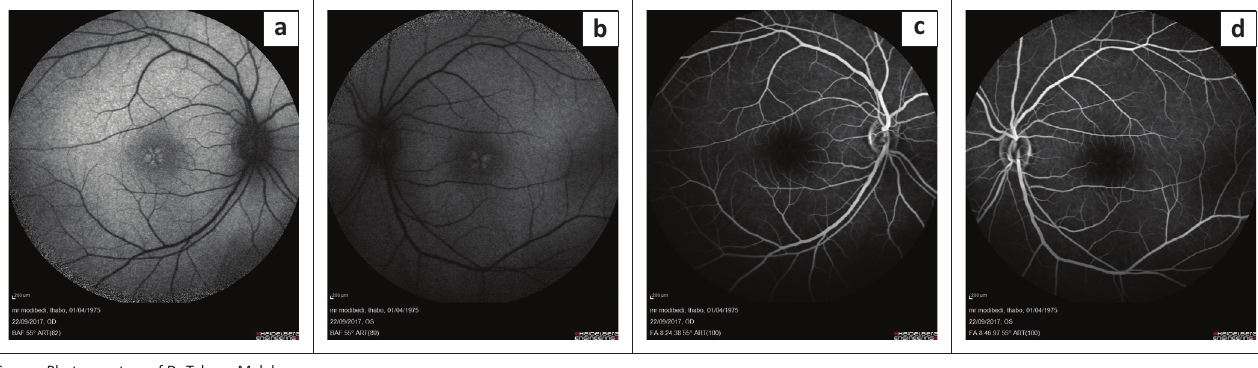
FIGURE 2: (a, b) Fundus autofluorescence (FAF) and (c, d) fundus fluorescein angiography (FFA) images of the right and left eye respectively. In the fundus autofluorescence images the ‘spoke-like’ pattern is clearly highlighted. The fundus fluorescein angiography shows no active leakage, with mild pooling at the